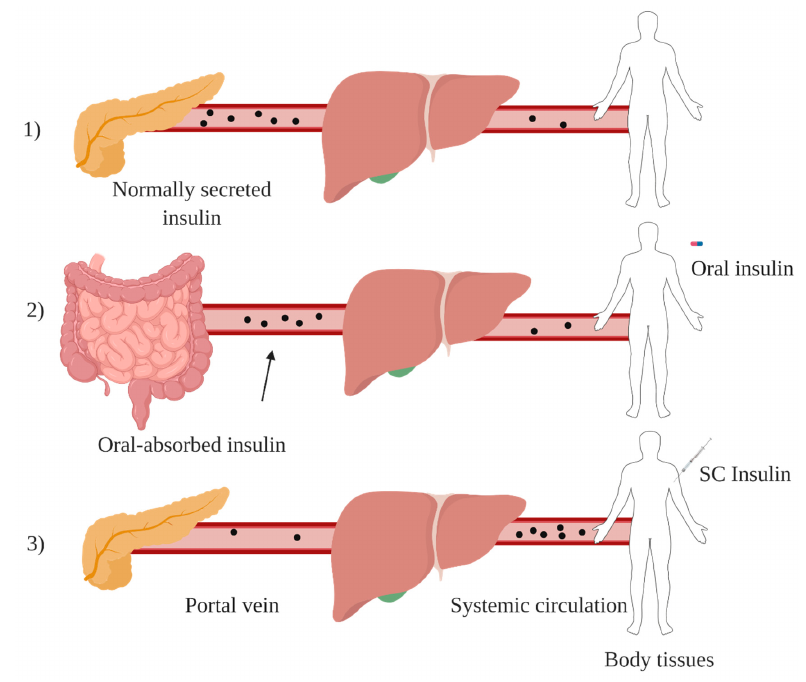
Figure 3. Endogenous insulin pathway under normal physiology ( 1 ), orally administered insulin pathway ( 2 ) and injected insulin pathway in diabetic patients ( 3 ). Created with BioRender.com.